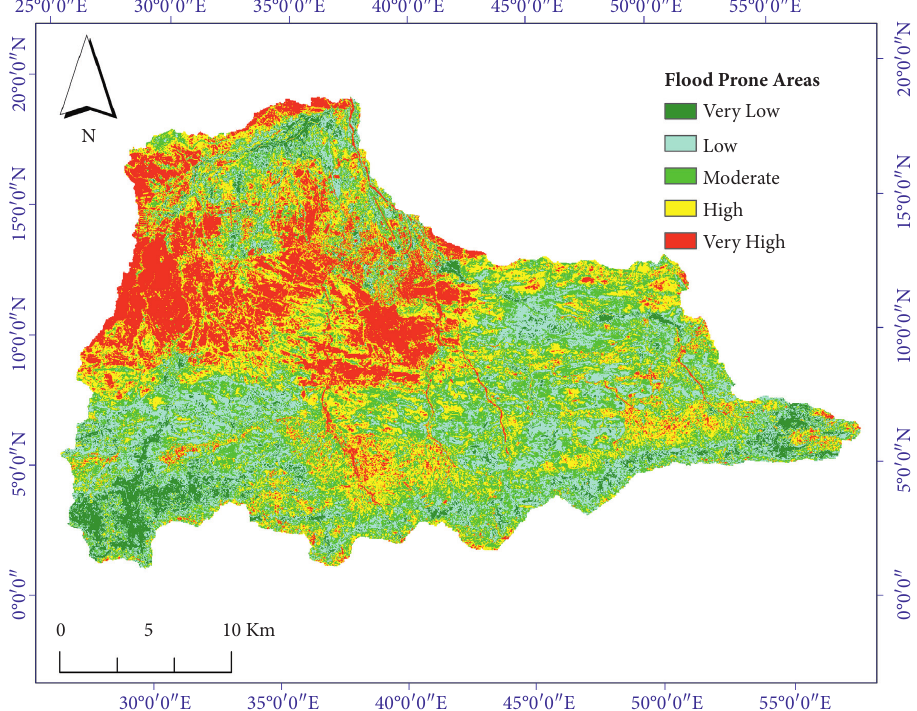
Figure 9: Identified flood prone areas in Dire Dawa